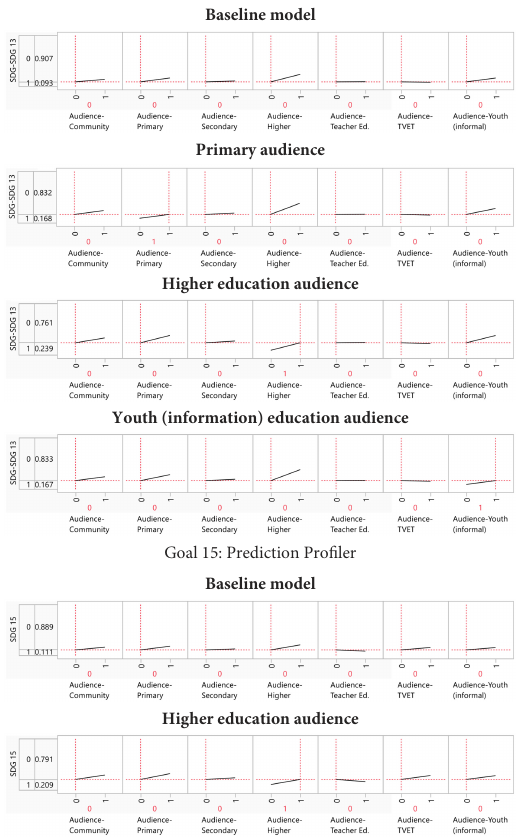
TABLE 6 Prediction profiler on the likelihood of RCE projects to focus on specific audiences of learners for SDG 13 (Climate Action) and SDG 15 (Life on